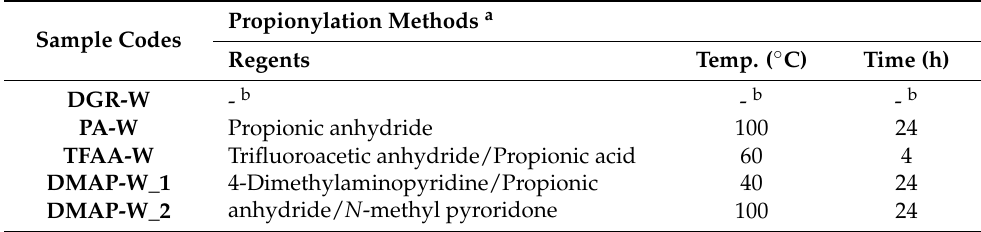
Table 1. Sample code of the synthesized woods and description of the propionylation methods. Sample